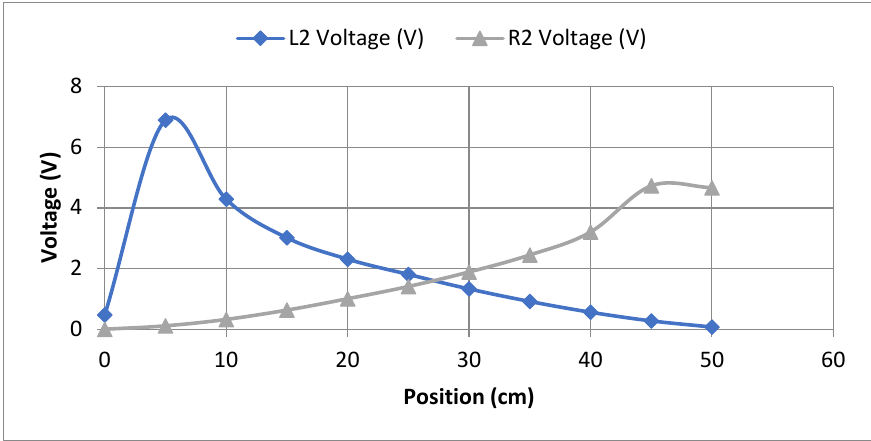
Figure 8. L2 and R2 sensors’ voltage reading for a 0.5 m/s load speed.